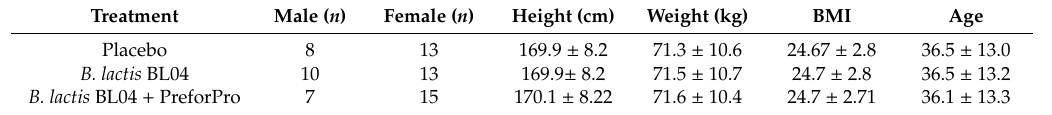
Table 2. Participant baseline characteristics.